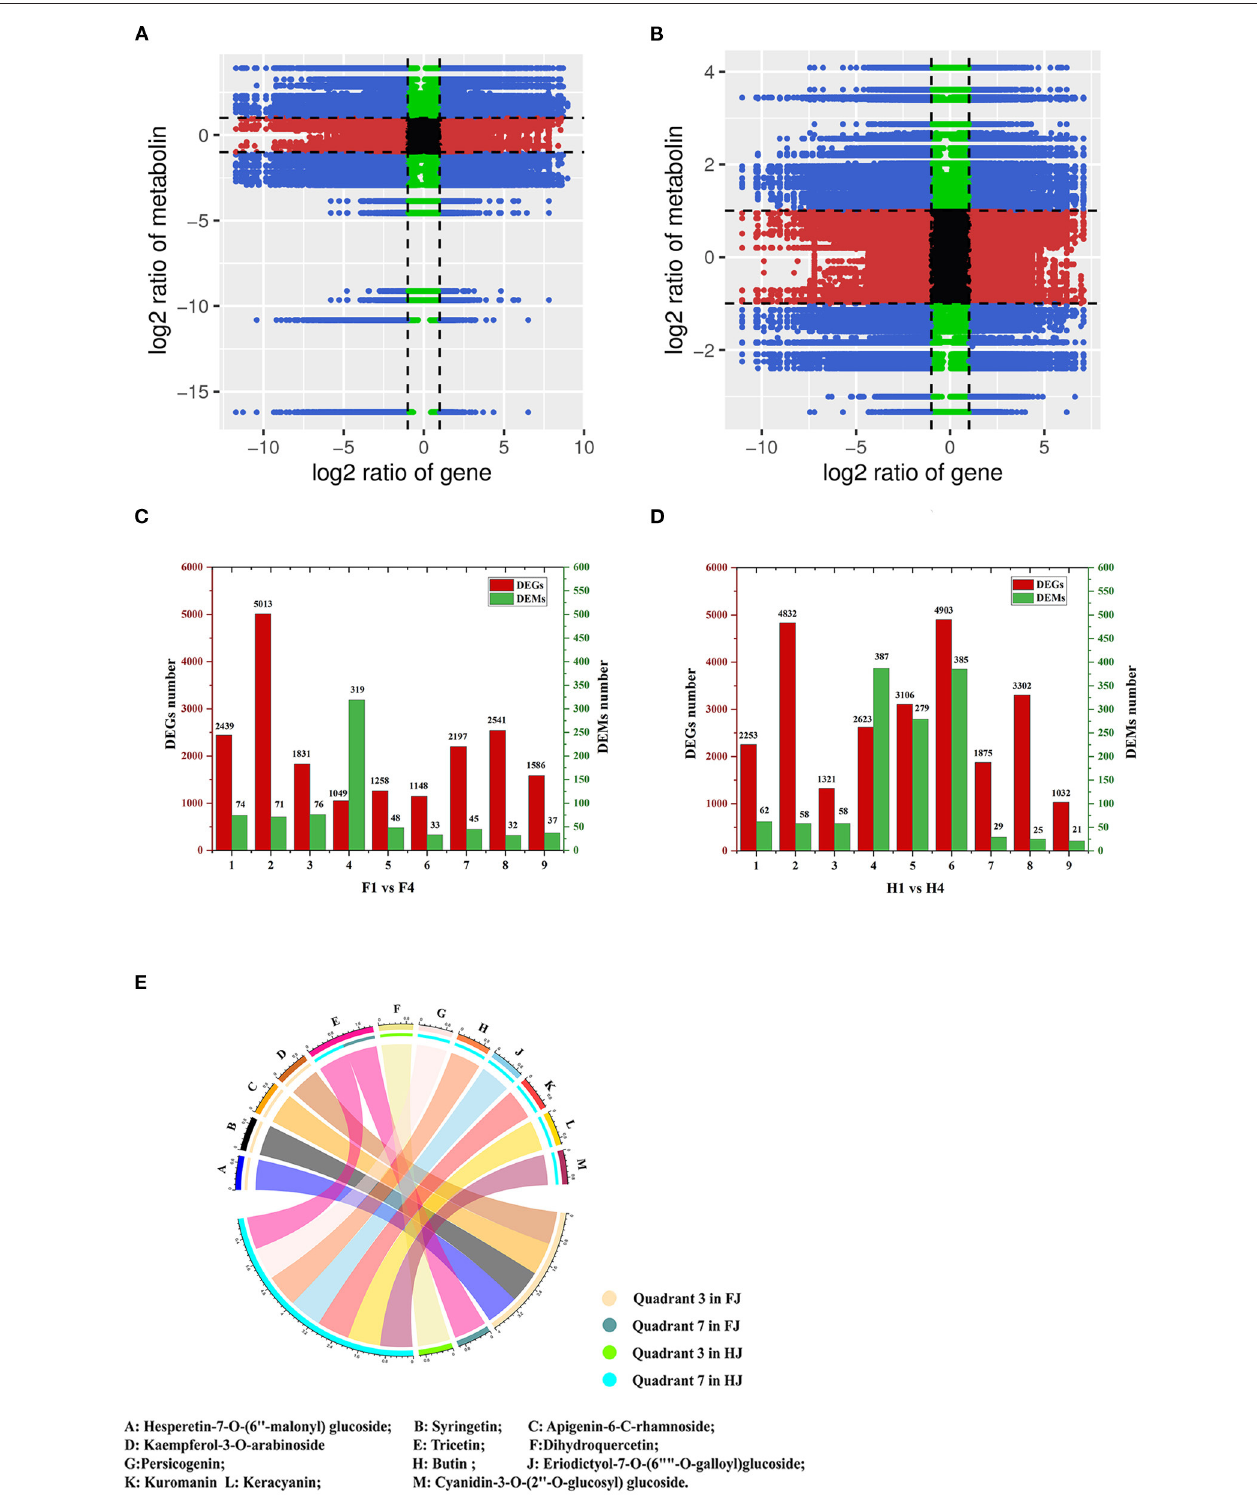
FIGURE 6 | Integrative analysis of DEGs and DAMs under drought stress in FJ and HJ. (A, B) : Nine-quadrant diagram of DEGs and DAMs in F1 vs. F4 and H1 vs. H4, respectively. (C, D) : The number of DEGs and DAMs in each quadrant in F1 vs. F4 and H1 vs. H4, respectively. (E) : DAFs in quadrant 3 and quadrant 7 in FJ and HJ.